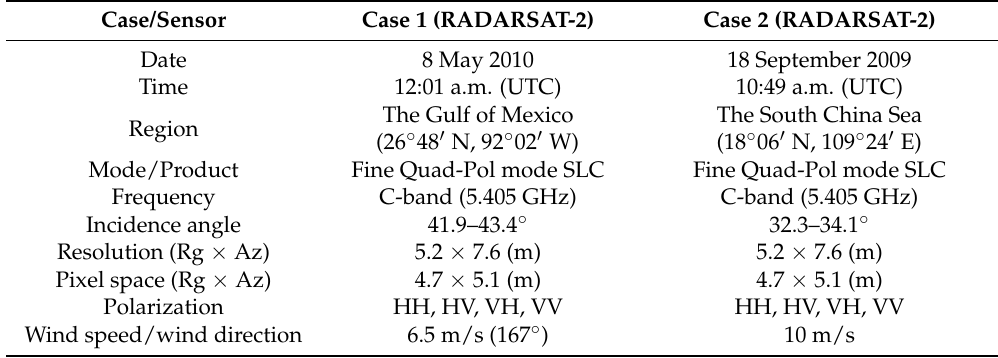
Table 1. Parameter properties of SAR data in two Cases.